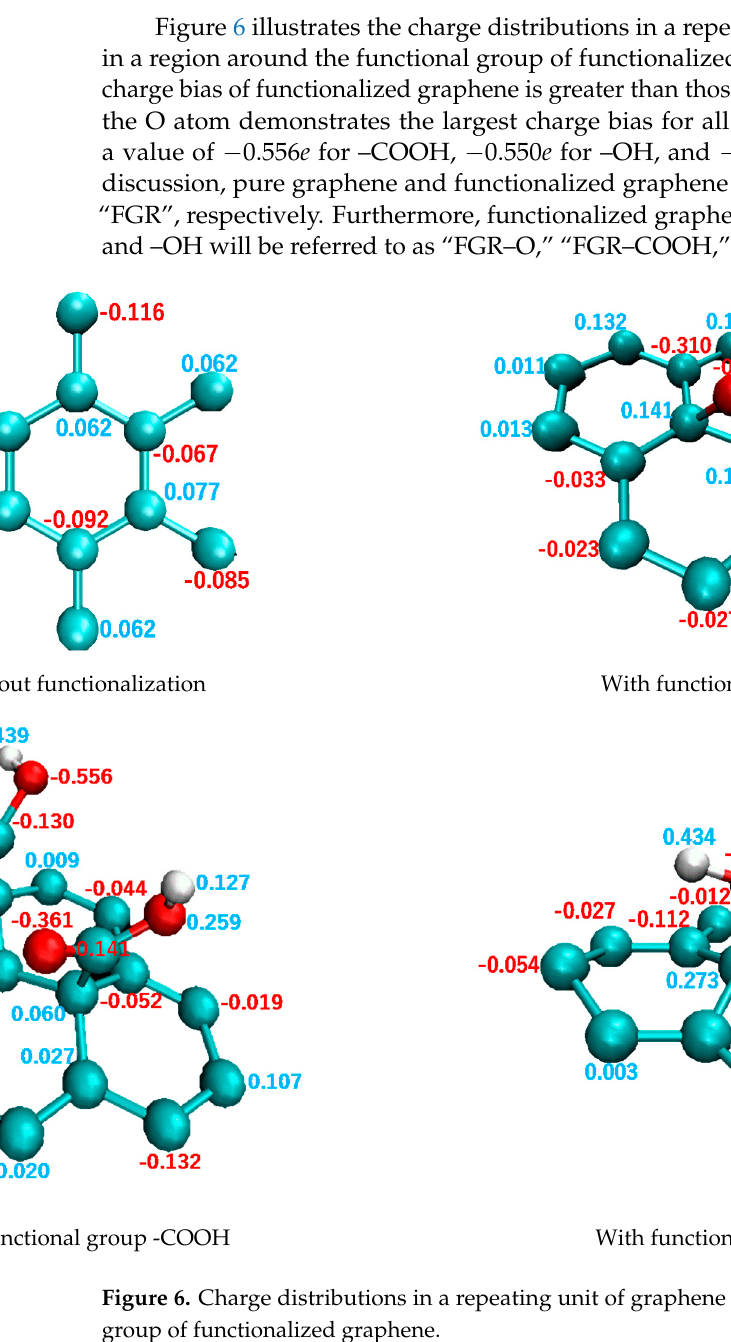
Figure 7. RDFs for atom pairs with positive and negative charge biases. ( a ) Functionalized graphene (FGR) modified with –OH, ( b ) FGR modified with –COOH, and ( c ) FGR modified with –O–. The upper and lower figures provide the corresponding data for PEI and PES, respectively.